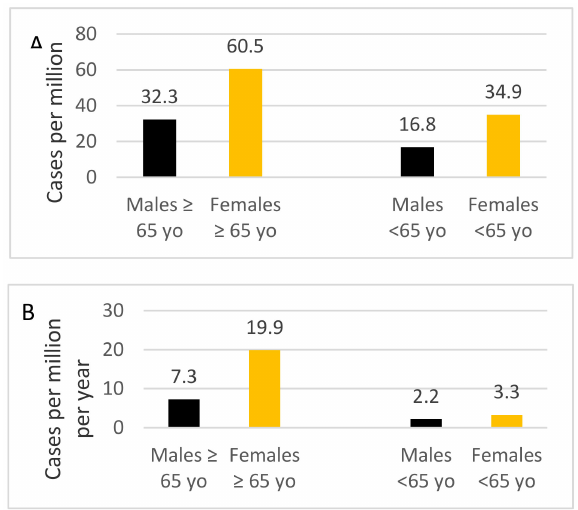
Figure 1. Prevalence ( A ) and incidence rate ( B ) of patients with PAH categorized by age and sex.